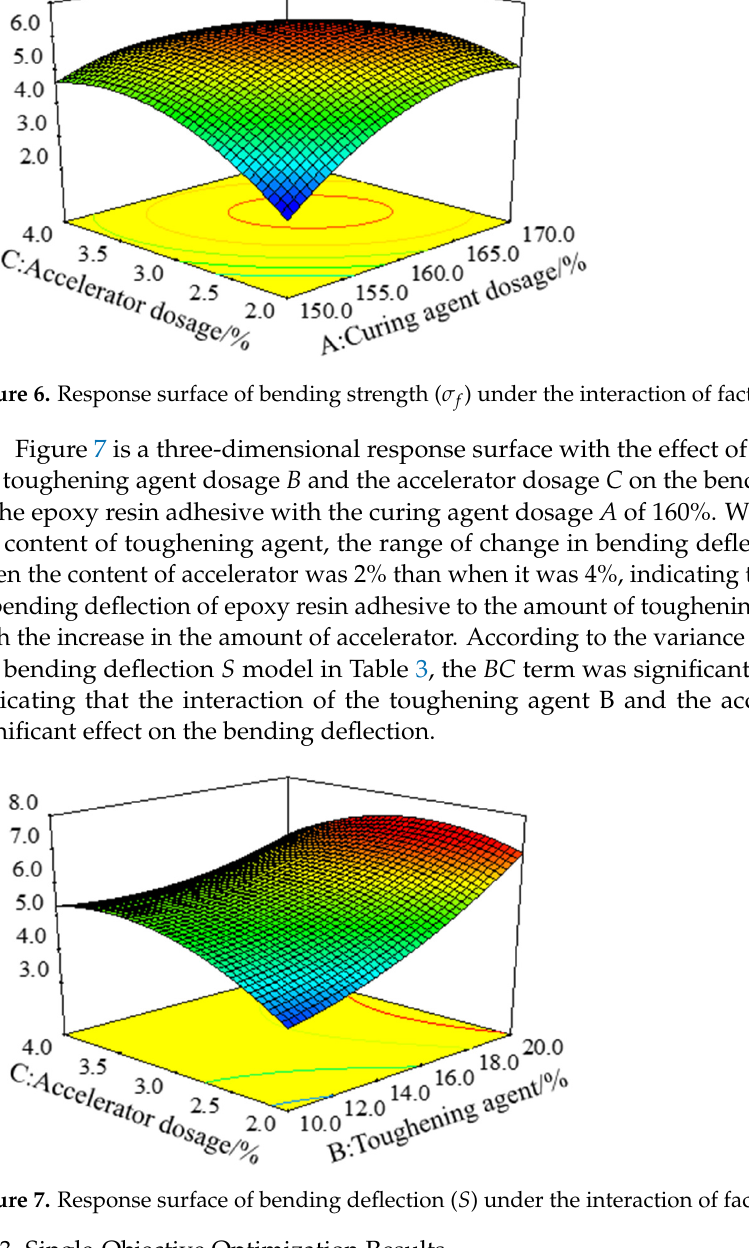
Figure 7. Response surface of bending deflection ( S ) under the interaction of factor B and factor C .